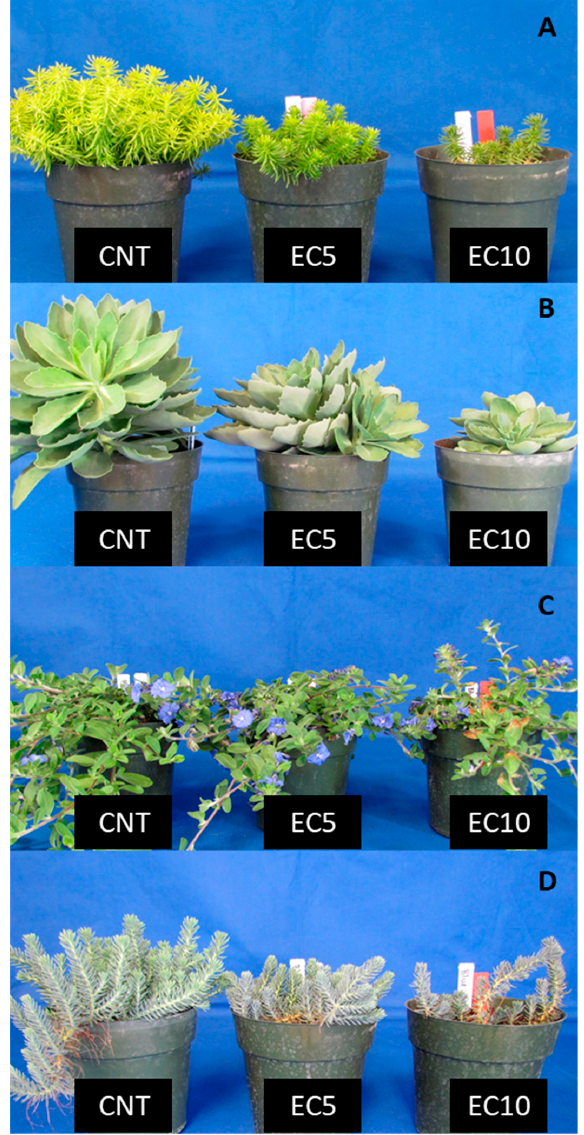
Figure 2. Representative photos of the four varieties of perennial ornamentals (Angelina ( A ), Autumn Joy ( B ), Blue Daze ( C ), and Blue Spruce ( D )) irrigated with control (CNT) or saline solutions for eight weeks. Photos were taken at termination of the experiment.